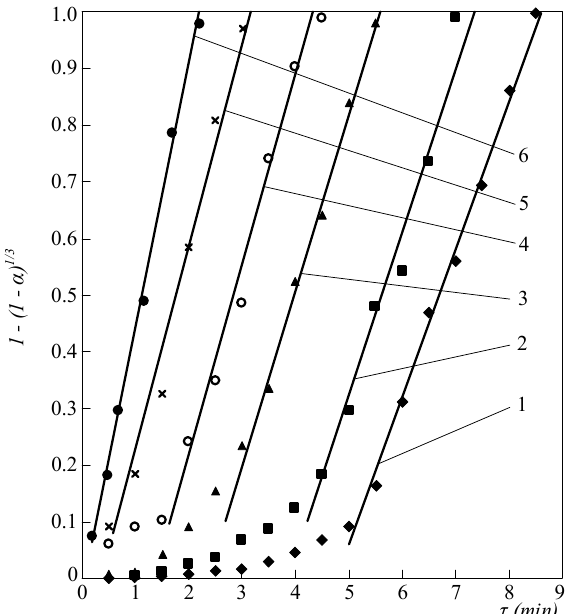
Figure 5. Dependence 1 − (1 −α ) 1/3 on time at fluorination temperatures:1—580; 2—630; 3—680; 4—730; 5—780; 6—830 K.